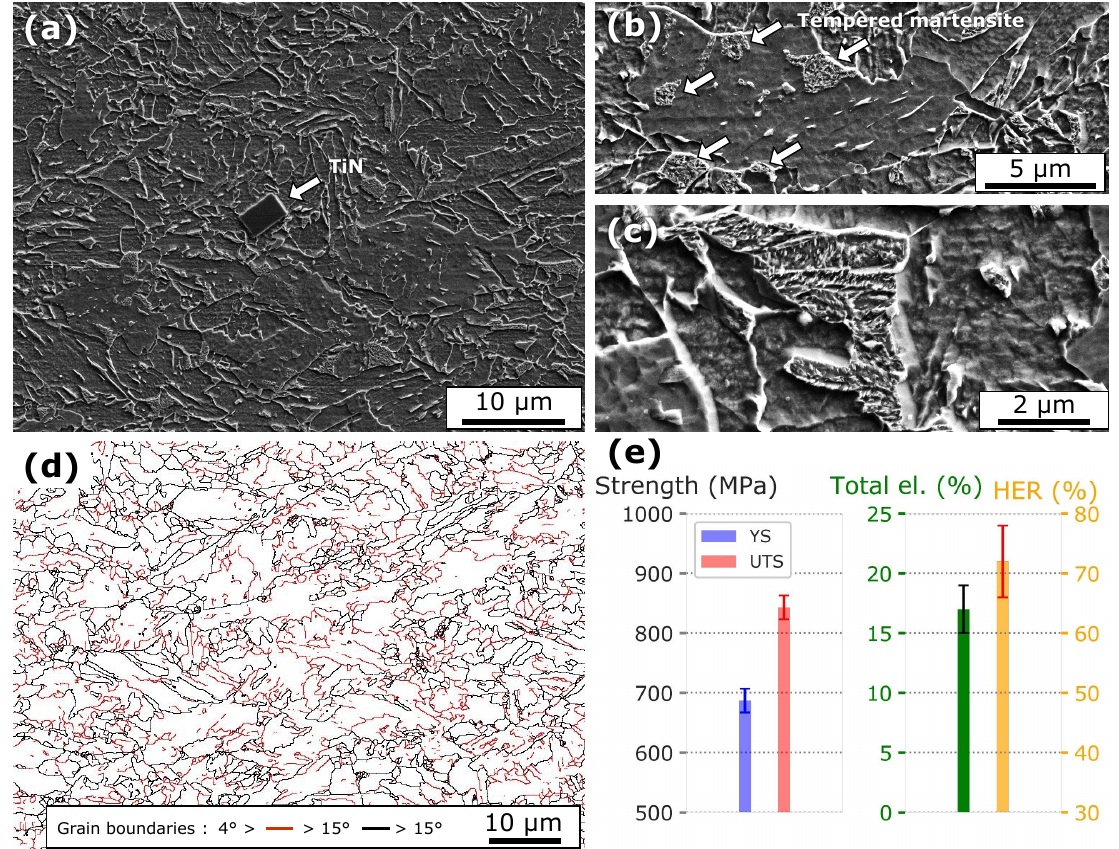
Figure 9. Microstructure of the industrial plate observed by SEM ( a – c ) and corresponding EBSD grain boundary map ( d ), consisting of a mixture of lath and granular bainite. Panel ( e ) shows the resulting tensile and hole expansion properties of this industrial